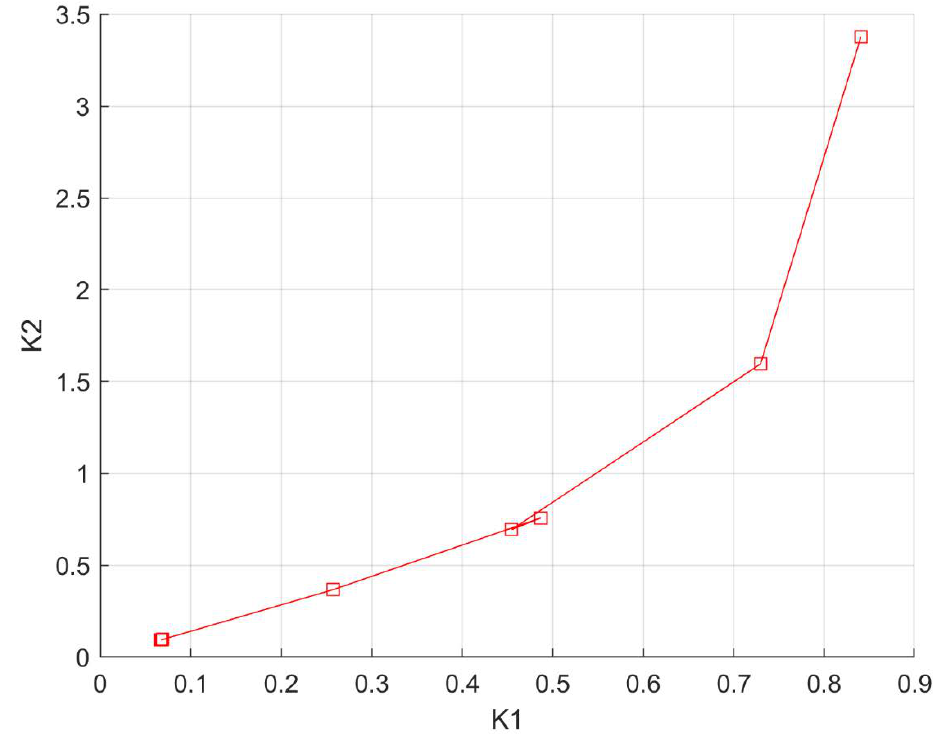
Figure 2. Pareto-optimal set for solving a problem by a method using a genetic algorithm.